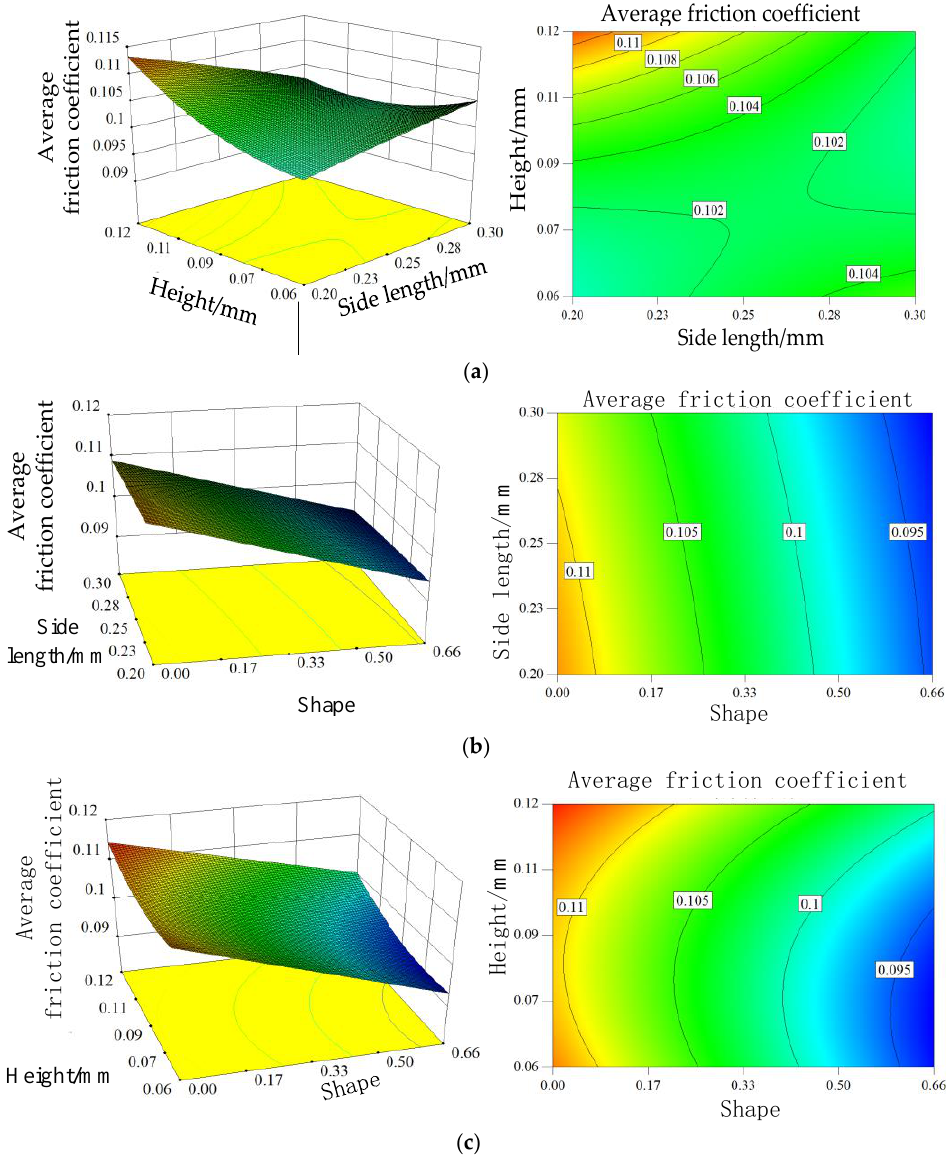
Figure 26. Effect of interaction of different variables on the friction coefficient of the woven surface. ( a ) Side length-height (weave shape = 0.33), ( b ) Side length-height (weave shape = 0.33), ( c ) Shape- height (weave edge length = 250 μm).